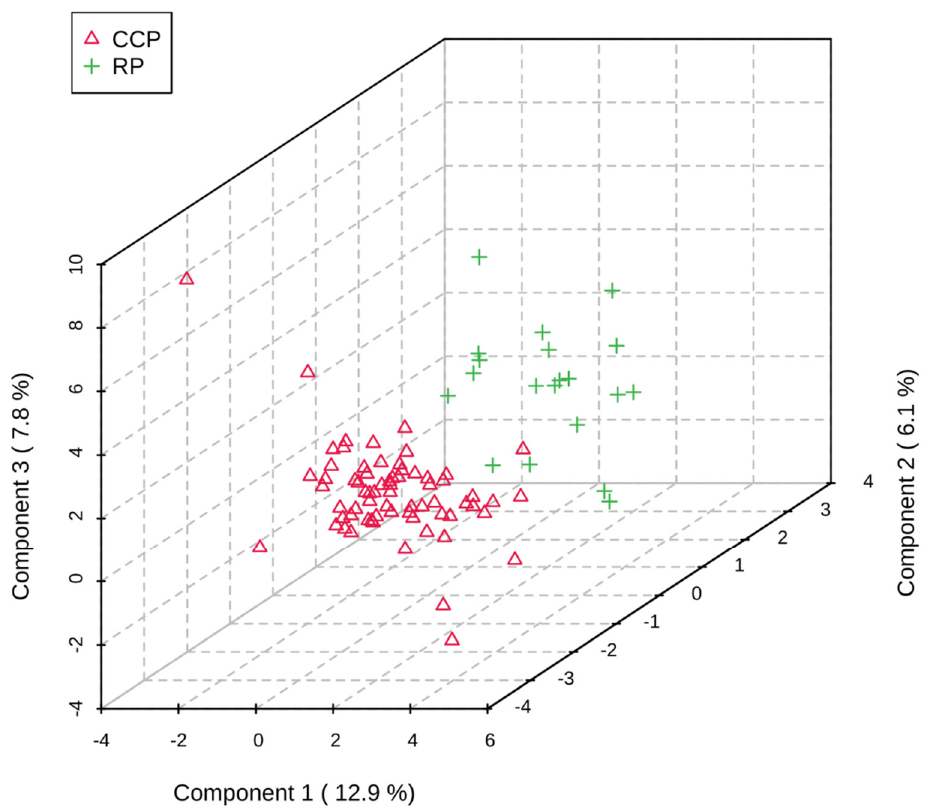
Figure 3. PLS-DA containing known metabolites and unidentified features detected during the CCP ( n = 68) and RP ( n = 20). The resulting plot shows separation between the groupings, indicating differences in the equine metabolomic profile during the CCP and the RP.